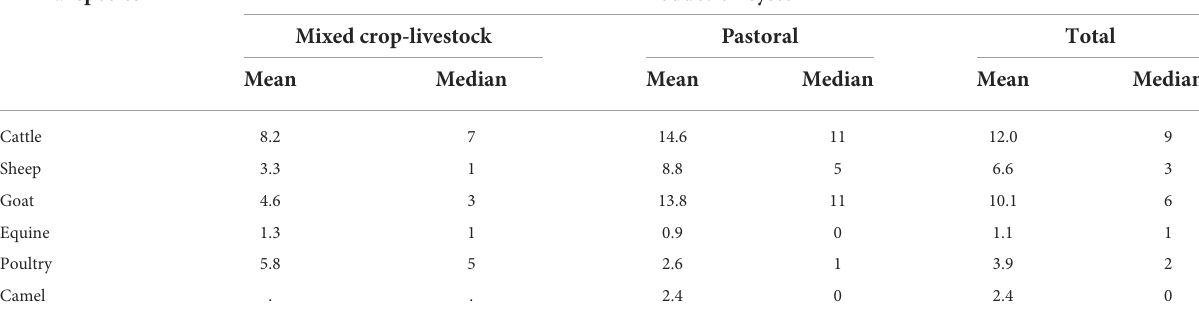
TABLE 2 Mean (median) number of animal species owned by study participants according to production systems. Animal